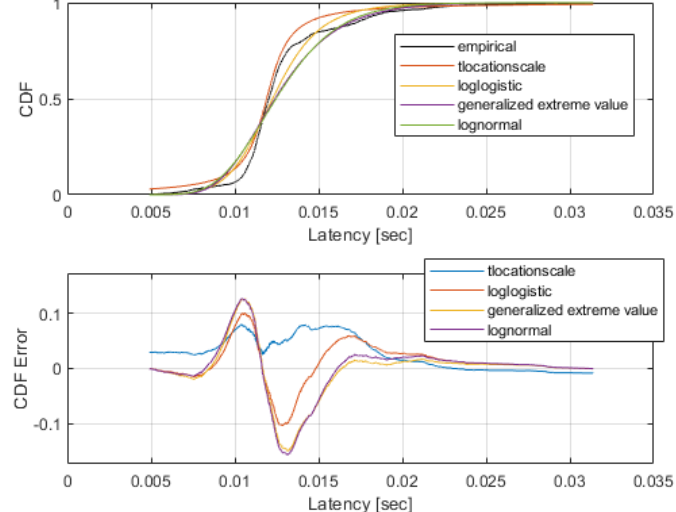
Figure 10. CDF and CDF error of the latency for empirical data and fitting distributions. Overall system (5G link and VLC link).